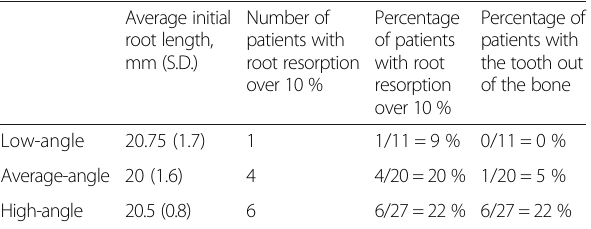
Table 2 Root resorption and roots out of the bone after orthodontic treatment in low-, average-, and high-angle patients Average initial root length, mm (S.D.)